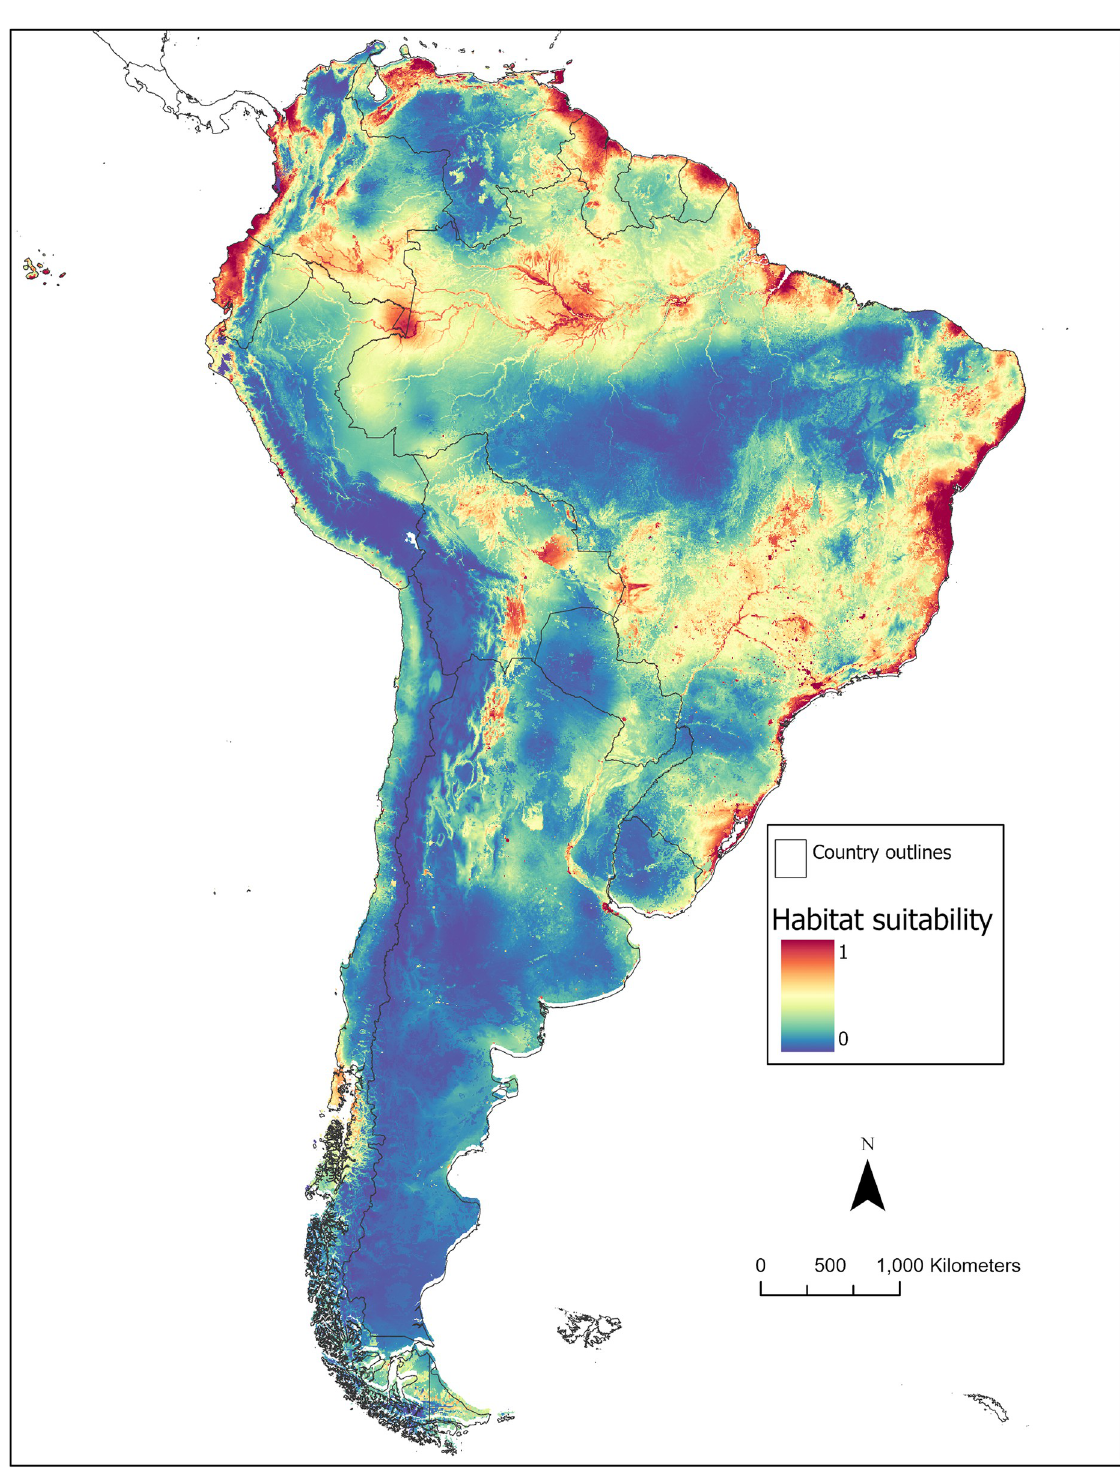
Fig 2. Estimated distribution of the Hg . janthinomys habitat suitability according to the MaxEnt models. Red represents areas of highest suitability for Hg . janthinomys while blue represents areas of low suitability. Base map sourced from Global Administrative Areas (GADM) version 4.0: https://gadm.org/download_country.html.